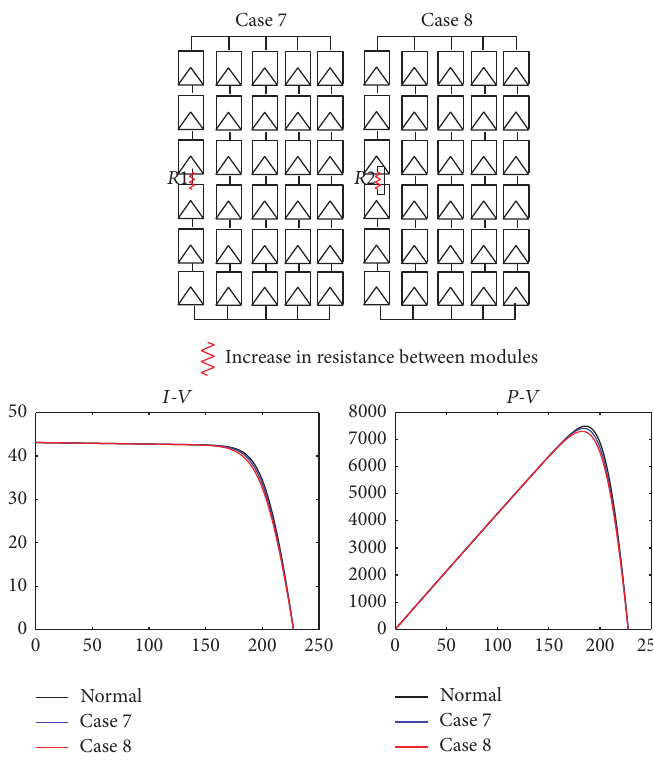
Figure 7: The PV array configuration for resistance between